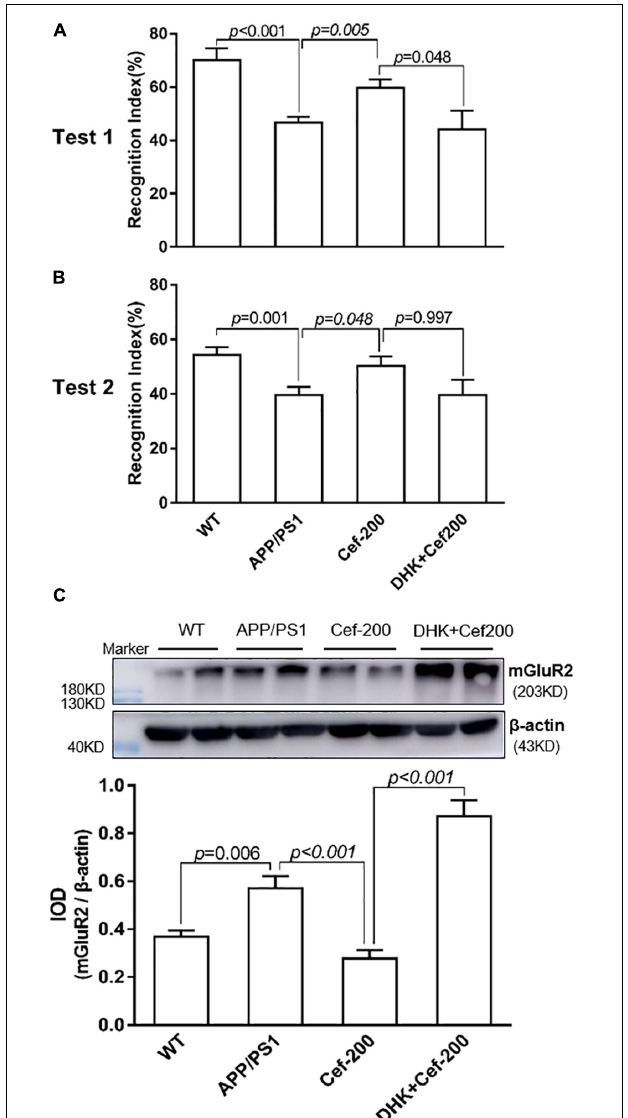
FIGURE 3 | DHK blocks Cef-induced improvement on recognition memory deficits and suppression on the mGluR2 protein expression in APP/PS1 mice. The histograms of (A,B) show the recognition index in test 1 (A) and test 2 (B) of the novel object recognition test. (C) Shows the expression of mGluR2 assayed by the Western blot analysis. The upper is a representative immunoblot and the lower is the quantitative presentation of the immunoblot with IOD. The number of mice for each test is shown in Table 1 . The italic values upon the bars are statistical P